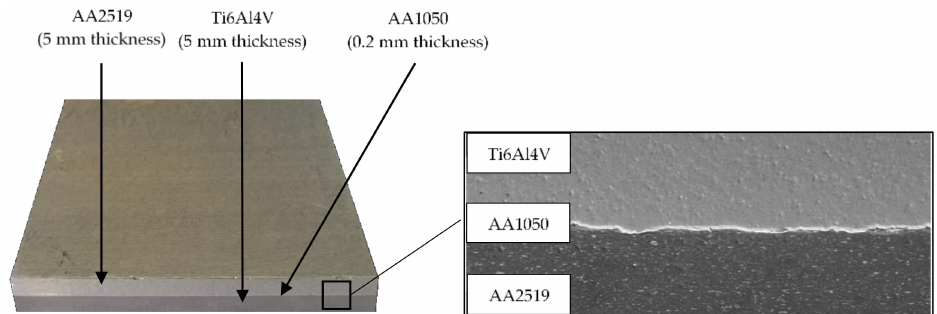
Figure 2. Layered material AA2519–AA1050–Ti6Al4V.